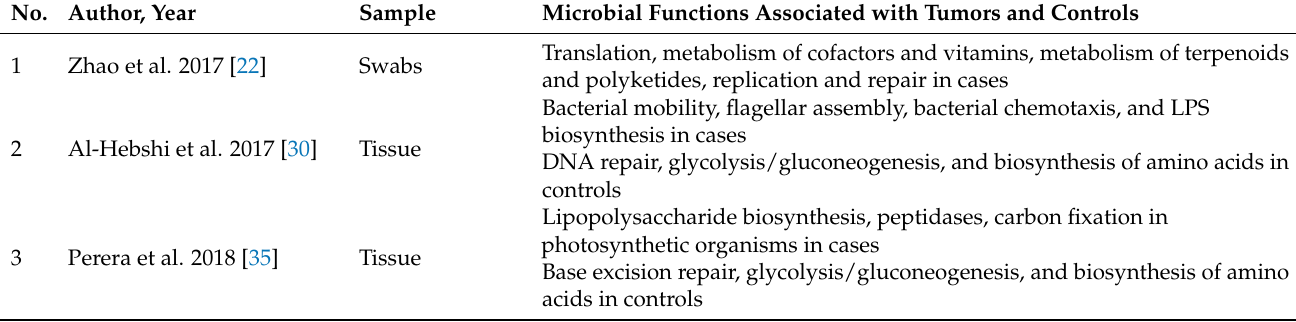
Table 3. Summary of highlighted Microbial